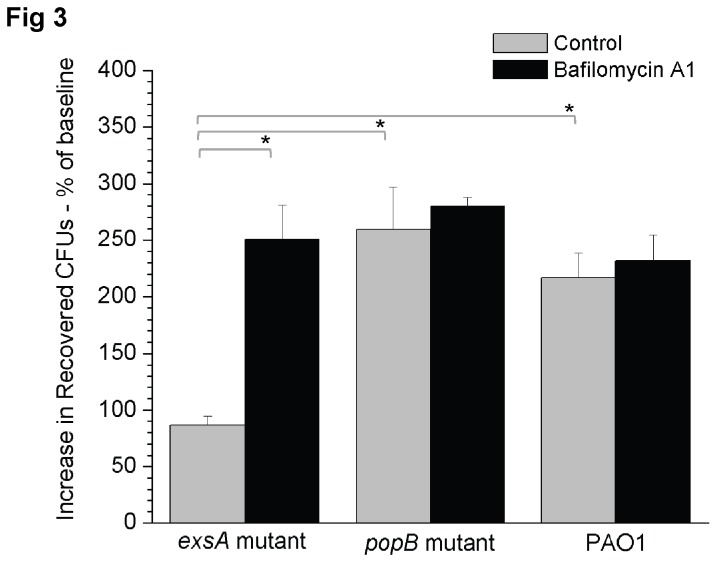
Intracellular survival and replication of P. aeruginosa PAO1 and its type III secretion mutants in corneal epithelial cells in the presence bafilomycin A1 (200 nM) (black boxes) versus control cells treated with vehicle only (grey boxes).Bafilomycin treatment restored intracellular survival of the exsA mutant to that of the popB mutant and wild-type PAO1. Bafilomycin A1 was added 1 h before infection and continued throughout the assay. Intracellular survival was expressed as the mean percentage increase in viable intracellular bacteria at 8 h versus 4 h post-infection (+/- SEM). A representative experiment of 3 independent experiments in shown above. ANOVA (p = 0.0002) and Welch’s corrected t-test were used for statistical analysis (* p < 0.05).